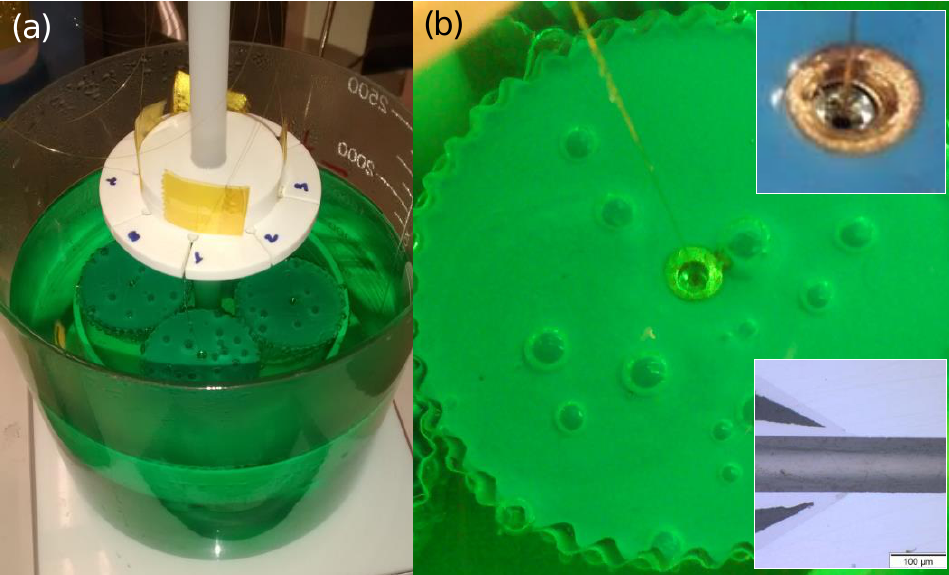
Figure 9. ( a ) Chemical nickel/phosphorous bath during a fiber/ferrule metallization process and ( b ) fiber ferrule sealed in the nickel ferrule after the metallization process.